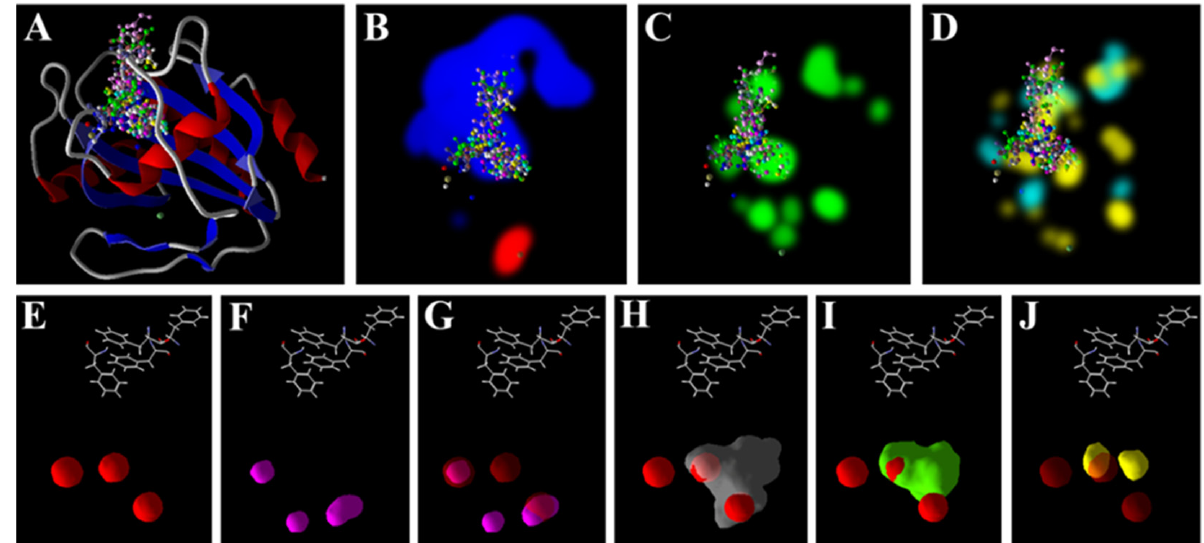
Figure 4. Docking poses and interactions of GPx of rice. ( A ) All docked ligands at the active site; surfaces of the receptor (along with the docked ligands) that favor ( B ) electrostatic, ( C ) stearic and ( D ) hydrogen bond interactions. Electrostatic surfaces of ( E ) As 3+ , ( F ) Zn 2+ , and overlapped surfaces of ( G ) As 3+ and Zn 2+ , ( H ) As 3+ and GSH, ( I ) As 3+ and AsA, and ( J ) As 3+ and H 2 O 2 . Poses and surfaces were developed using MVD.